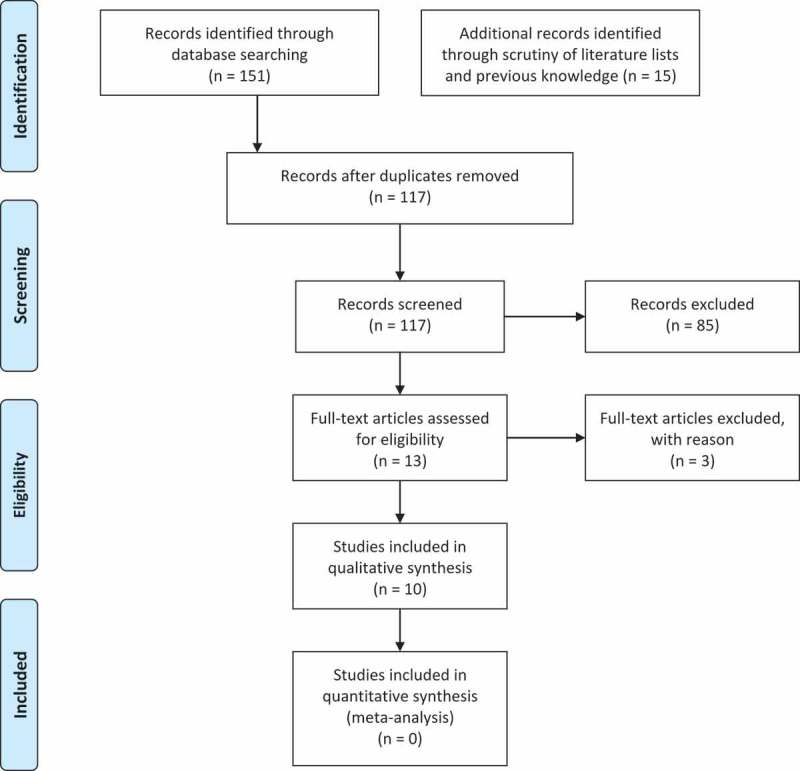
PRISMA flow diagram [8].